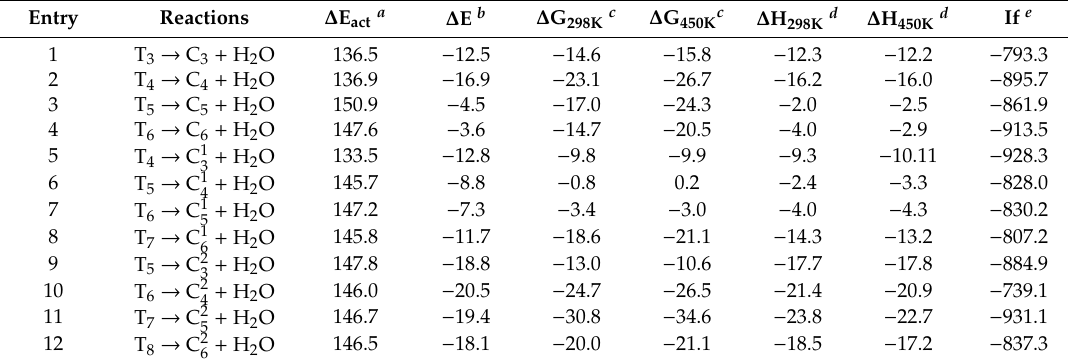
Table 4. Energy profile (kJ / mol) for the formation of cyclic oligomers through the MAM mechanism.